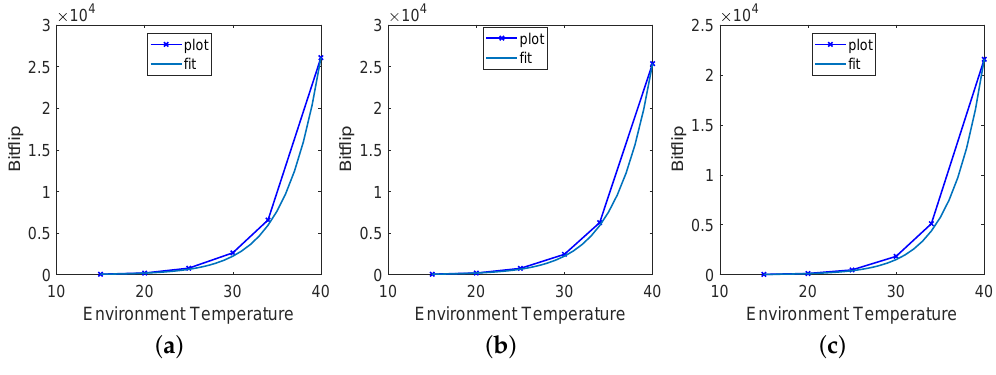
Figure 9. Fitting line of Rpi1, Rpi2 and Rpi3. The smooth curve is the fitting line and the line with the “’X” lable is the original line. ( a ) Fitting line of Rpi1. ( b ) Fitting line of Rpi2. ( c ) Fitting line of